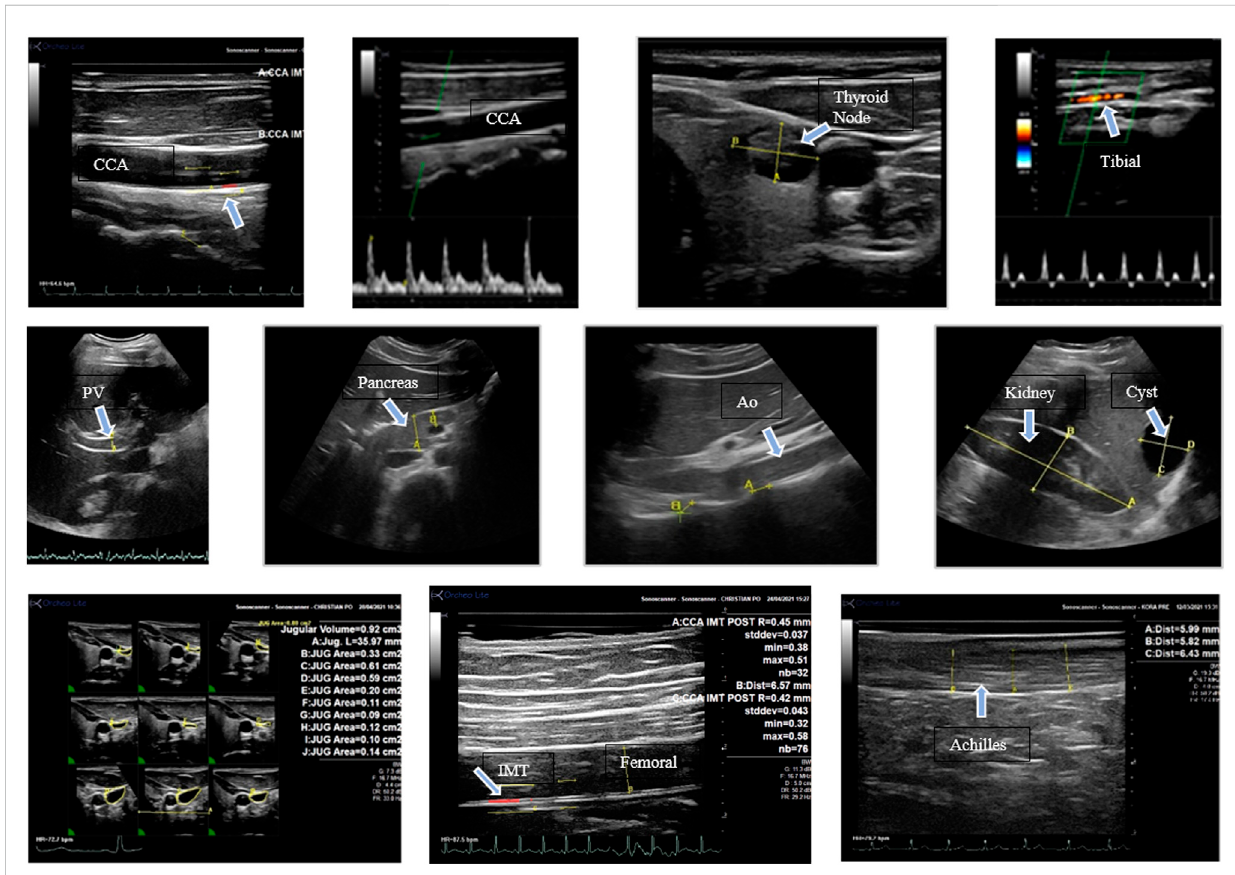
FIGURE 2 Images witharrowsindicating variousstructuresassessedinthisstudy.Theimagesaredescribedfromlefttoright.Toprow:longitudinalviewofthe common carotid artery; (CC) carotid Doppler velocity; thyroid with a nodule; tibial artery Doppler velocity. Middle row: portal vein (A); head of the pancreas;abdominalaorta(Ao)andlumbarvertebraldistance;kidney(A-B)andlivercyst(C-D).Bottomrow:jugularveinvolumemeasurementsfromthe 3D reconstruction, femoral artery IMT, Achilles tendon